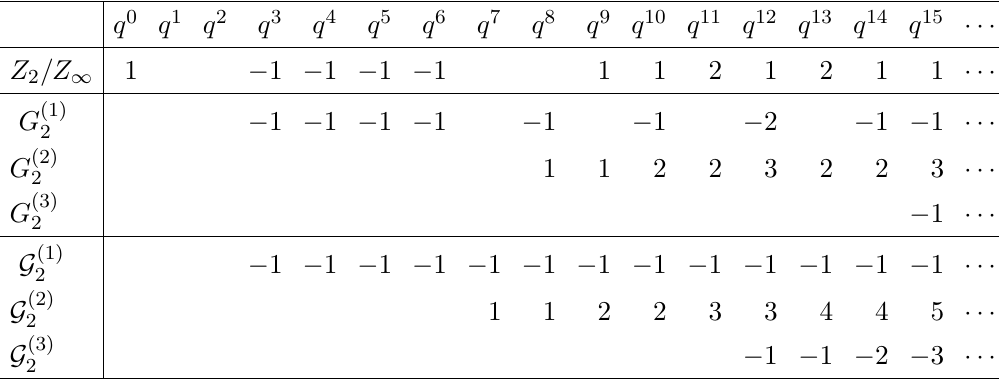
given in (2.33). N given in N